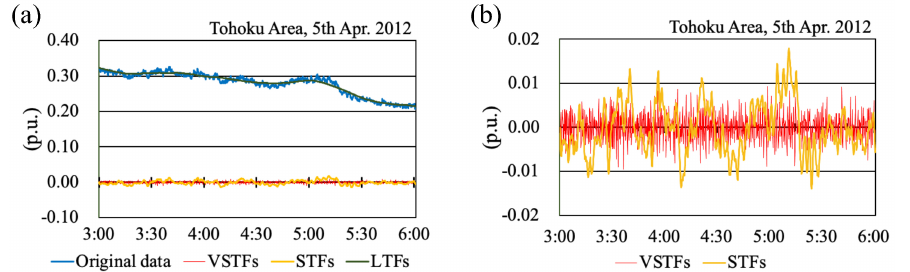
Figure 4. Time series of ( a ) wind power output and very short-, short-, and long-term fluctuations, and ( b ) very short- and short-term fluctuations. Parameters X = 1 min and Y = 30